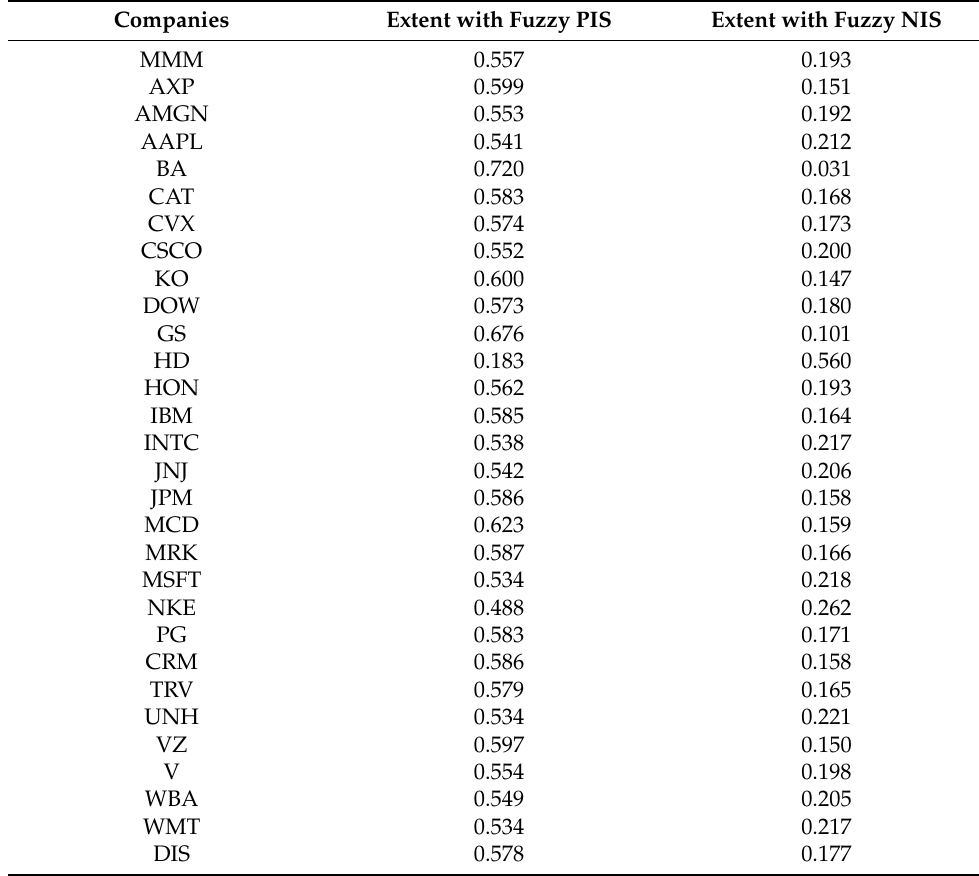
Table 9. Extent of all companies with fuzzy PIS and fuzzy